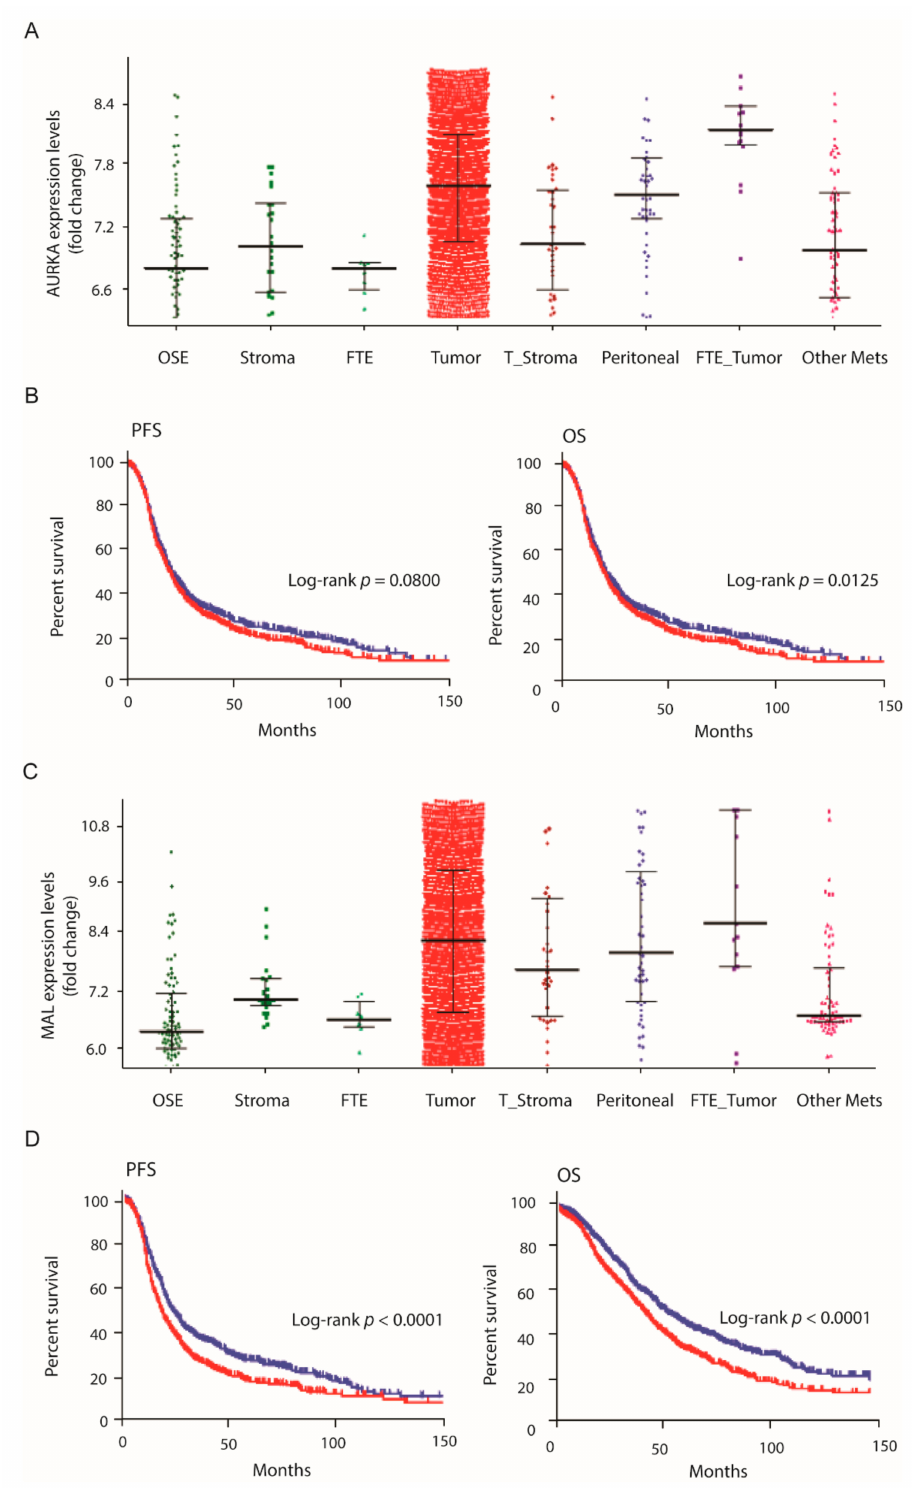
Figure 5. Gene-expression in ovarian cancer. Gene expression profiles of ( A ) AURKA and ( C ) MAL in normal tissue, including ovarian surface epithelium (OSE), stroma and fallopian tube epithelium (FTE), and the ovarian cancer disease state are shown. The correlation of gene expression with the PFS and OS of ovarian cancer patients is presented in ( B , D ), respectively. Kaplan–Meier plots were generated with samples of low (blue) and high (red) gene expression levels within the CSIOVDB